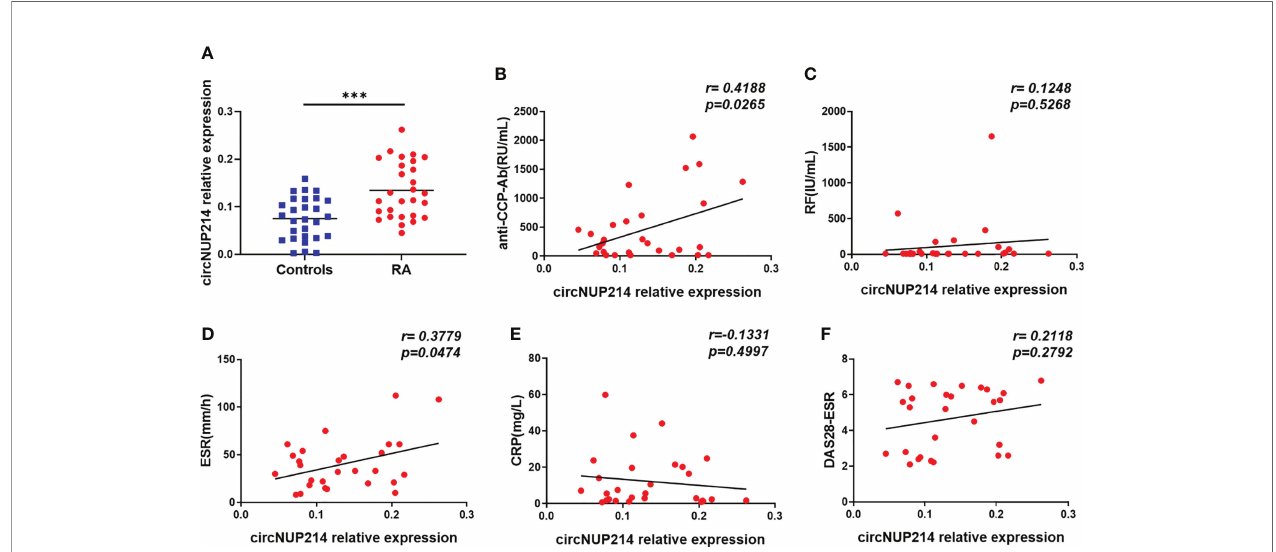
FIGURE 2 | Increased circNUP214 expression in RA patients. (A) The transcript levels of circNUP214 in PBMCs from 28 RA patientsand 28 controlswere determined by qRT – PCR. The correlations between circNUP214 expression and the concentrations of anti-CCP Ab (B) , RF (C) , ESR (D) , CRP (E) , and DAS28-ESR score (F) in 28 RA patients are shown. Each data point represents an individual subject, and the horizontal lines show the mean. *** p <